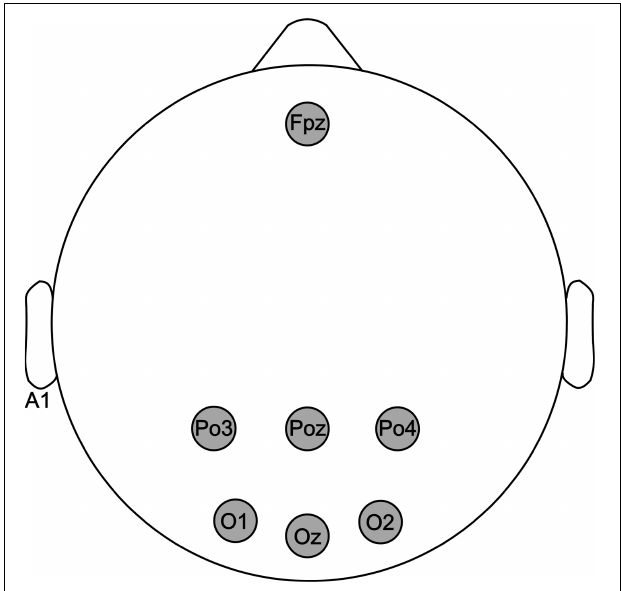
FIGURE 1 | Electrode montage used in this study. EEG signals were recorded from six electrodes: PO3, POz, PO4, O1, Oz, and O2.